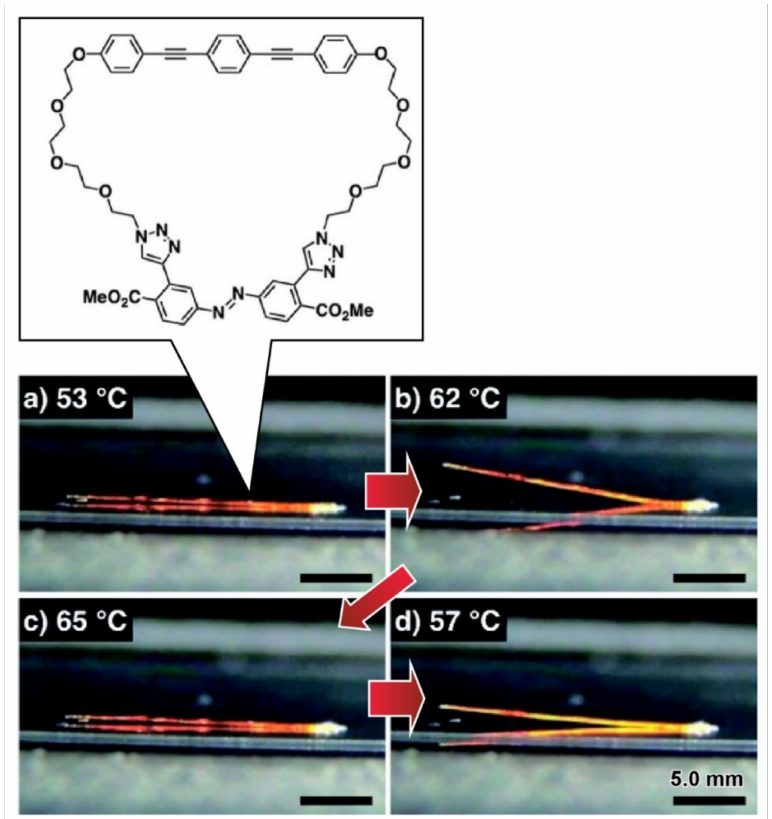
Figure 21. Single crystals with needle shapes formed with the macrocyclic compound with two tetra(ethylene glycol)s, bis(phenylethynyl)benzene moiety, and trans-azobenzene unit with reversible bending motions upon polymorphic transition between single crystal states upon heating. Reprinted with permission from Reference [166]. Copyright 2020 Chemical Society of